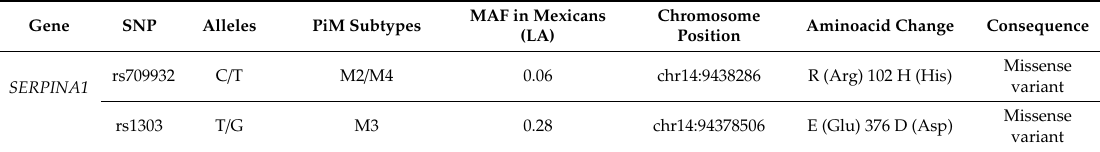
Table 5. Characteristics of